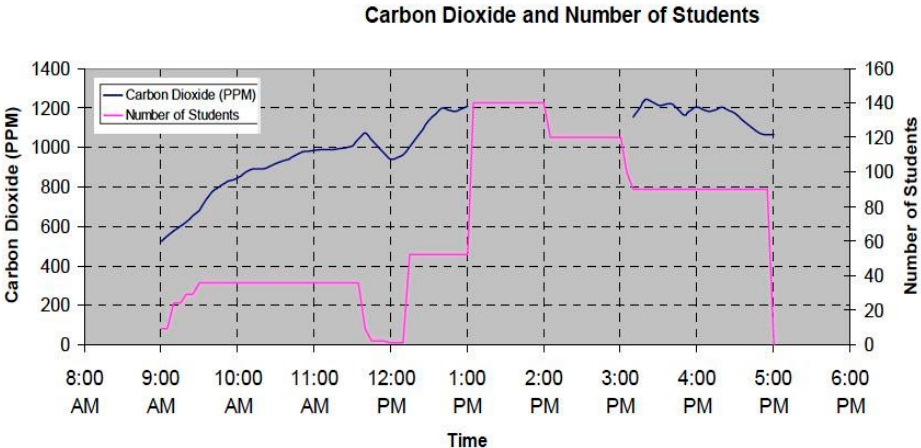
Figure 3. Measured temperature increase due to the addition of occupants in the classroom.